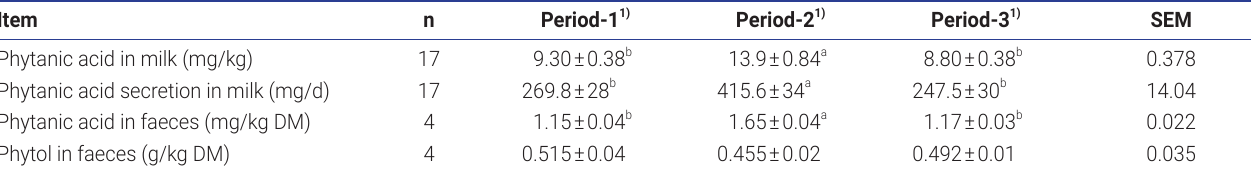
Table 5. Effects of feeding periods on milk and feces phytanic acid in dairy cows